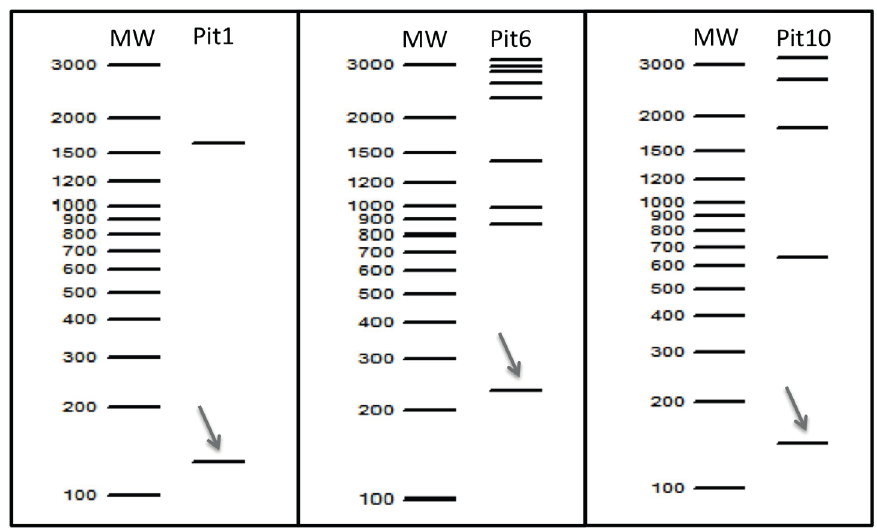
Figure 1 - Virtual electrophoresis gel from in silico amplification of three SSR loci discovered using low coverage sequencing of the Eugenia uniflora genome and selected for genotyping of 30 individuals of natural populations of the species. MW represents the molecular weight ladder. The arrow indicates the amplified SSR allele. For these three loci, a feasible amplification within the expected size is observed, leading to their